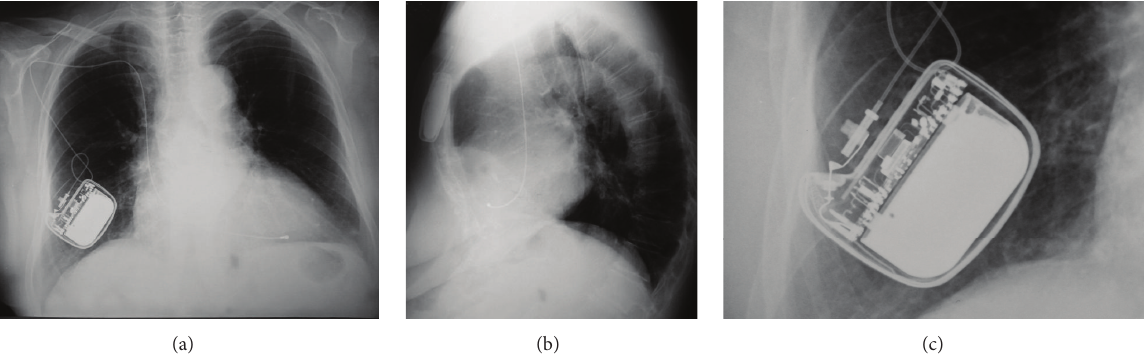
Figure 2: ((a), (b)) Chest X-ray (May 22, 2015) of anteroposterior and lateral views. (c) Enlargement of the pulse generator figure, showing the initial generator-lead connection, without the presence of IS-1 lead